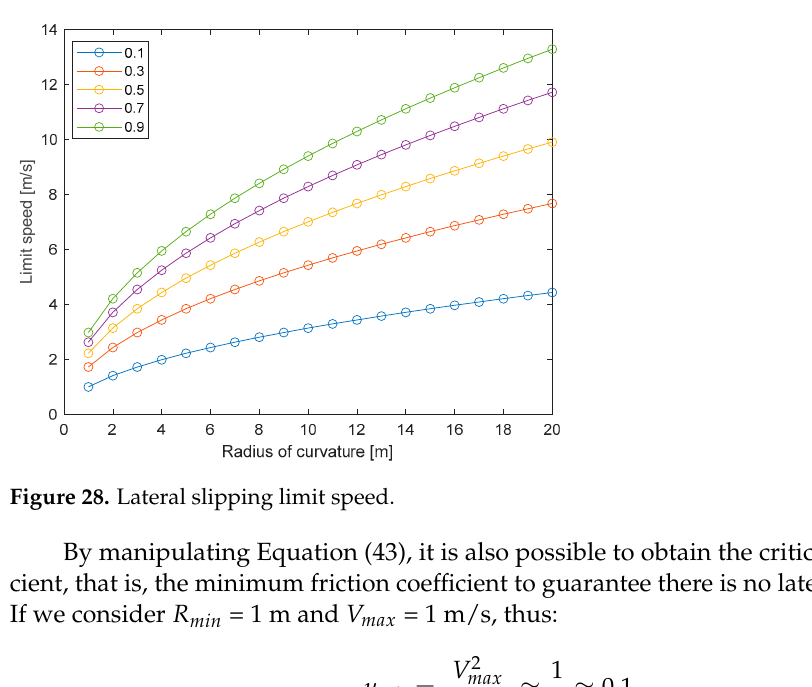
In Figure 30, the evolution of the limit speed with respect to the radius of the curve is represented. To obtain this figure, it has been assumed that the center of gravity is at h = 50 cm and 𝑏 (cid:2870) = 62 cm, which corresponds to possible real values. Other assumptions would be possible for different curves.